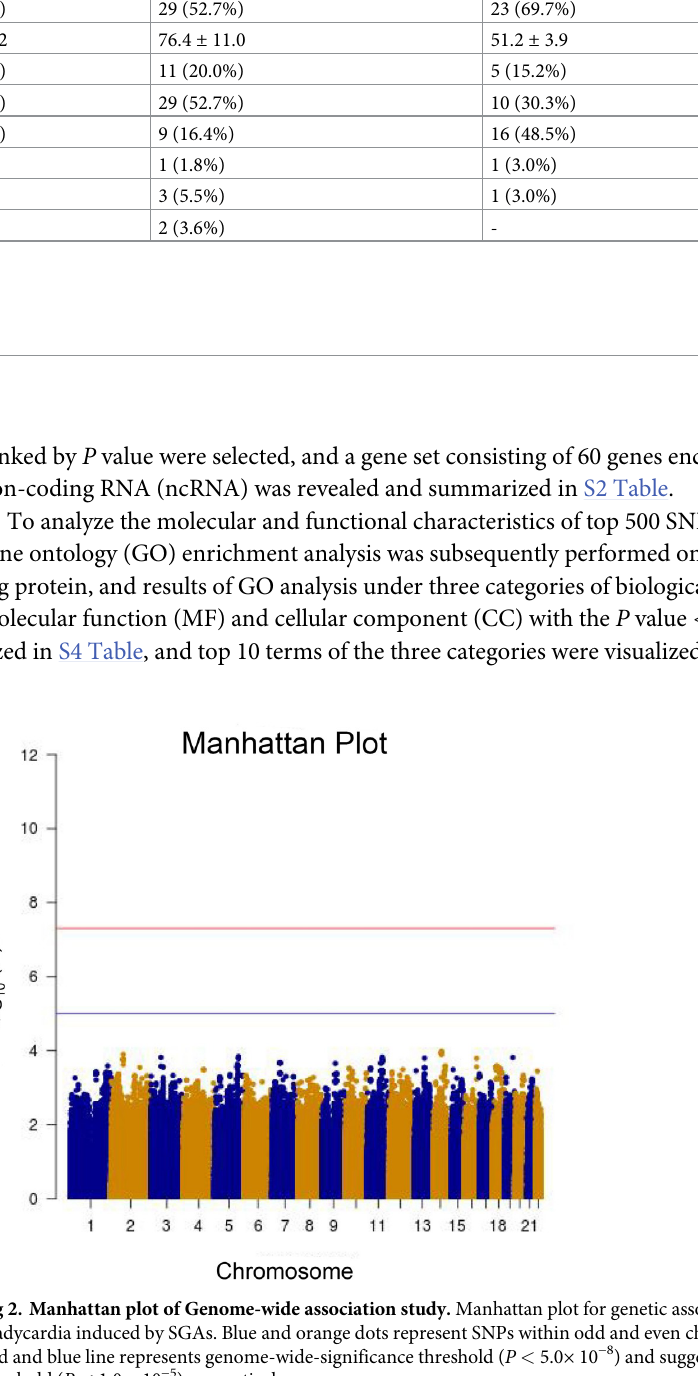
Fig 2. Manhattan plot of Genome-wide association study. Manhattan plot for genetic association study of sinus bradycardia induced by SGAs. Blue and orange dots represent SNPs within odd and even chromosomes, respectively. Red and blue line represents genome-wide-significance threshold ( P < 5.0 × 10 − 8 ) and suggestive significance threshold ( P < 1.0 × 10 − 5 ), respectively.